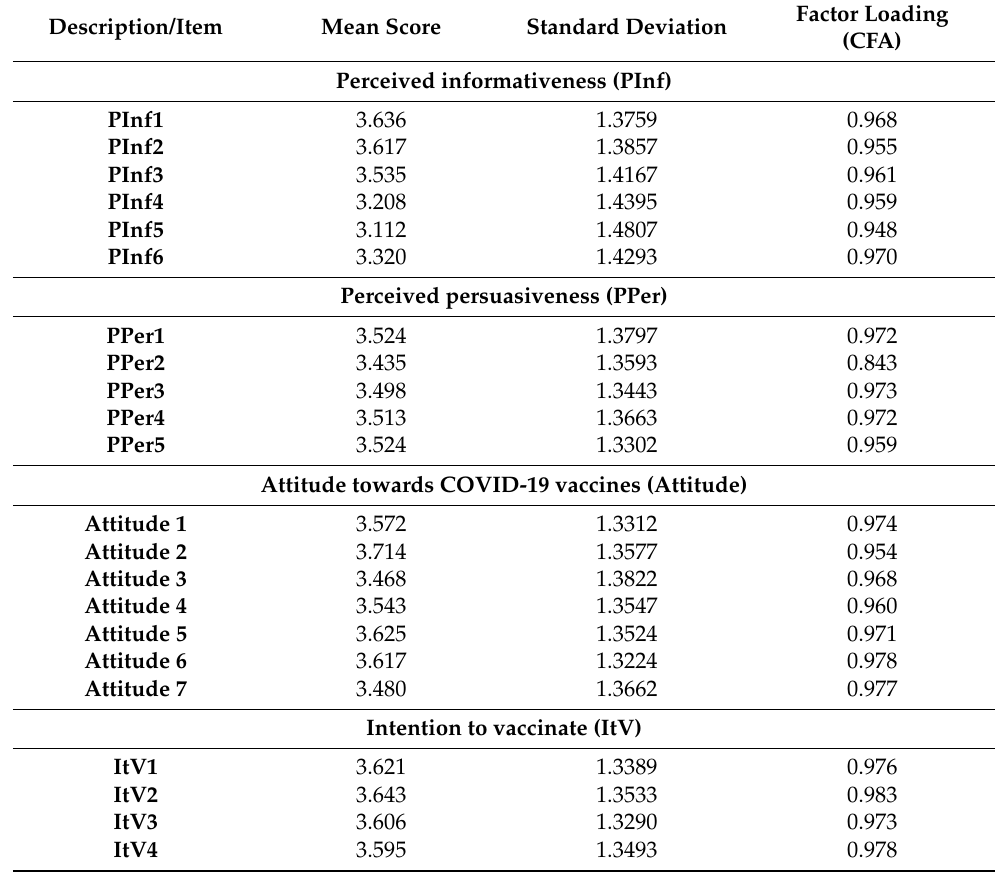
Table 2. Descriptive analysis for each construct and CFA.